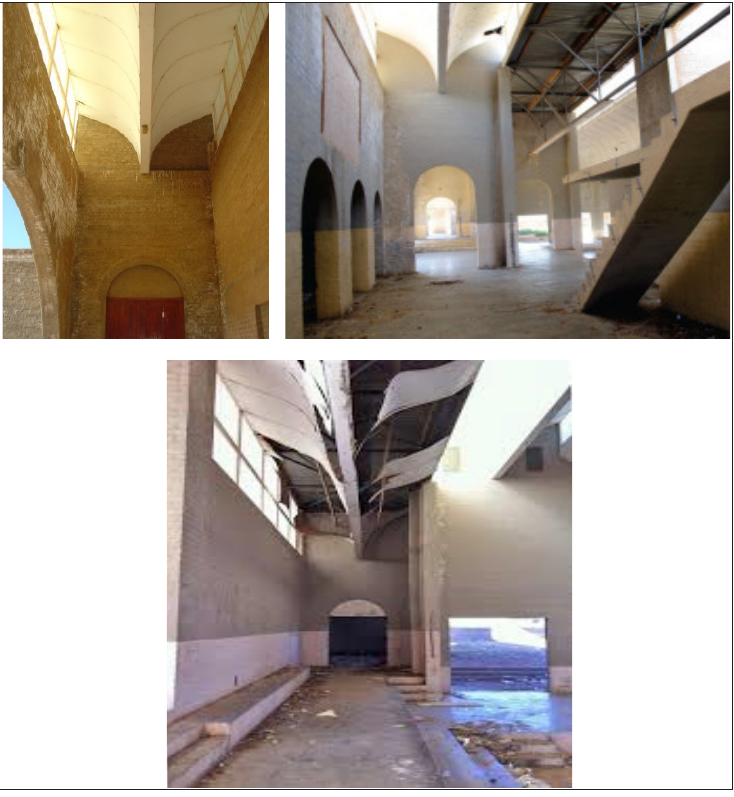
Figure 11: Steinkopf Community Centre, photo taken in 2007 (top) compared to recent photos of interior space in 2012 (bottom)